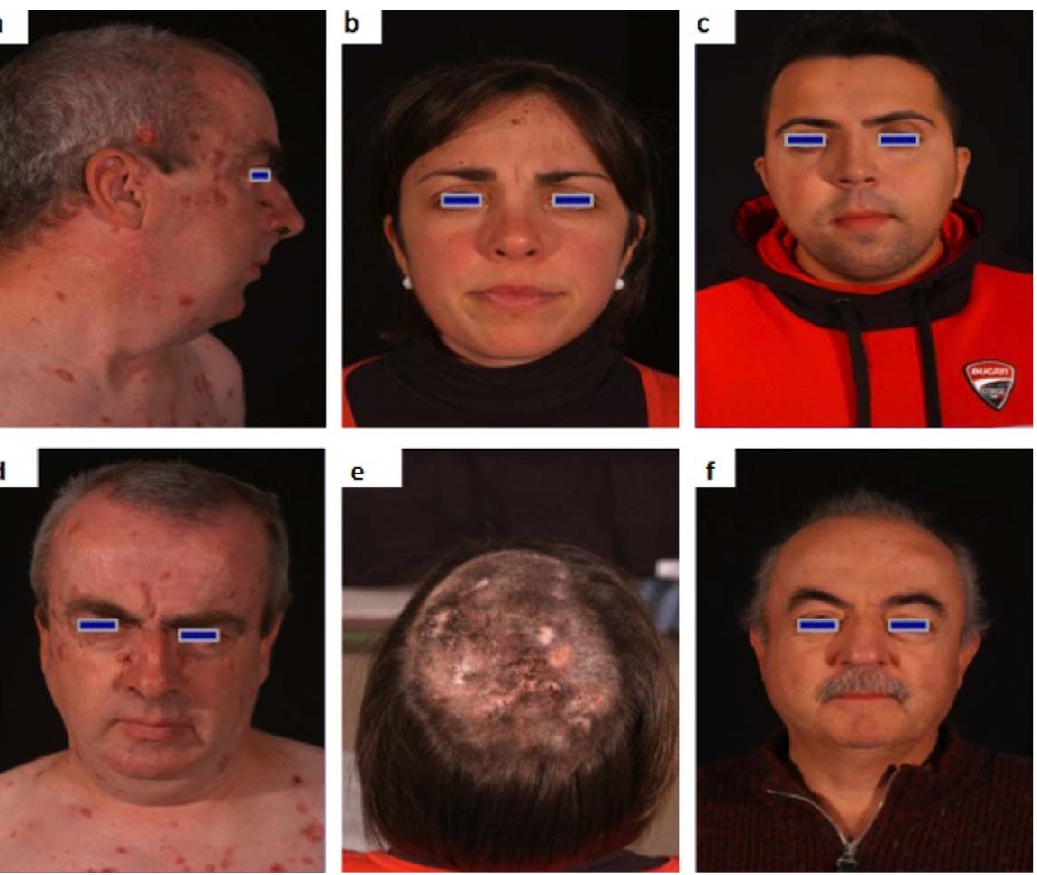
Figure 1. Clinical features of NBCCS’ patients (a, d : patient n. 3; b, e : patient n.16; c: n.11 proband’s’brother; d: n. 11 proband’s father; see Table 2).